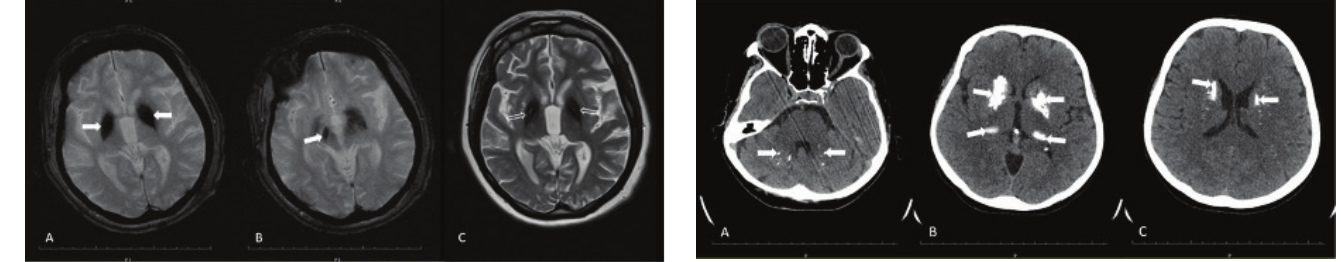
Figure 1 - Case 9: 22-year-old female patient with FAHR disease, loss of signal secondary to accumulation of paramagnetic substance in the lentiform nuclei and thalamus on gradient echo on brain MRI in A shown with bold white arrows, hyperintense signal change on axial T1 sections in B shown with light white arrows, presence of calcification at the same levels on axial CT sections in C shown with fine white arrows.